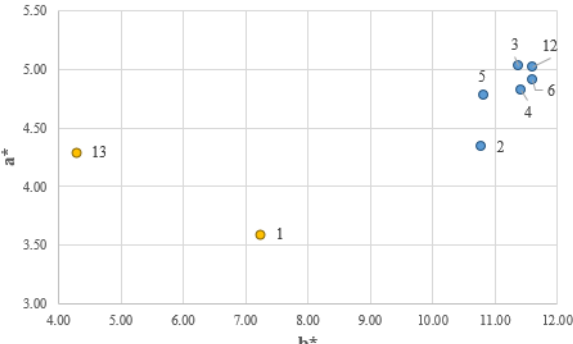
Figure 11. Colorimetric values of the samples. Yellow: Natural clays, Blue: Modified adobes.